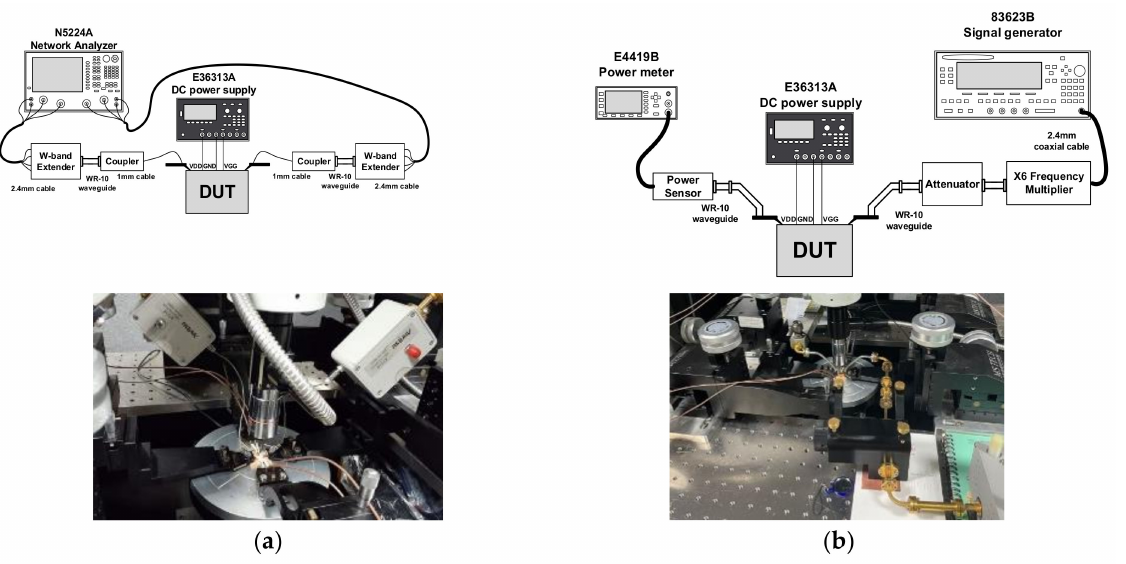
Figure 13. Measurement setup of the proposed W-band PA ( a ) S-parameters and ( b ) the large-signal